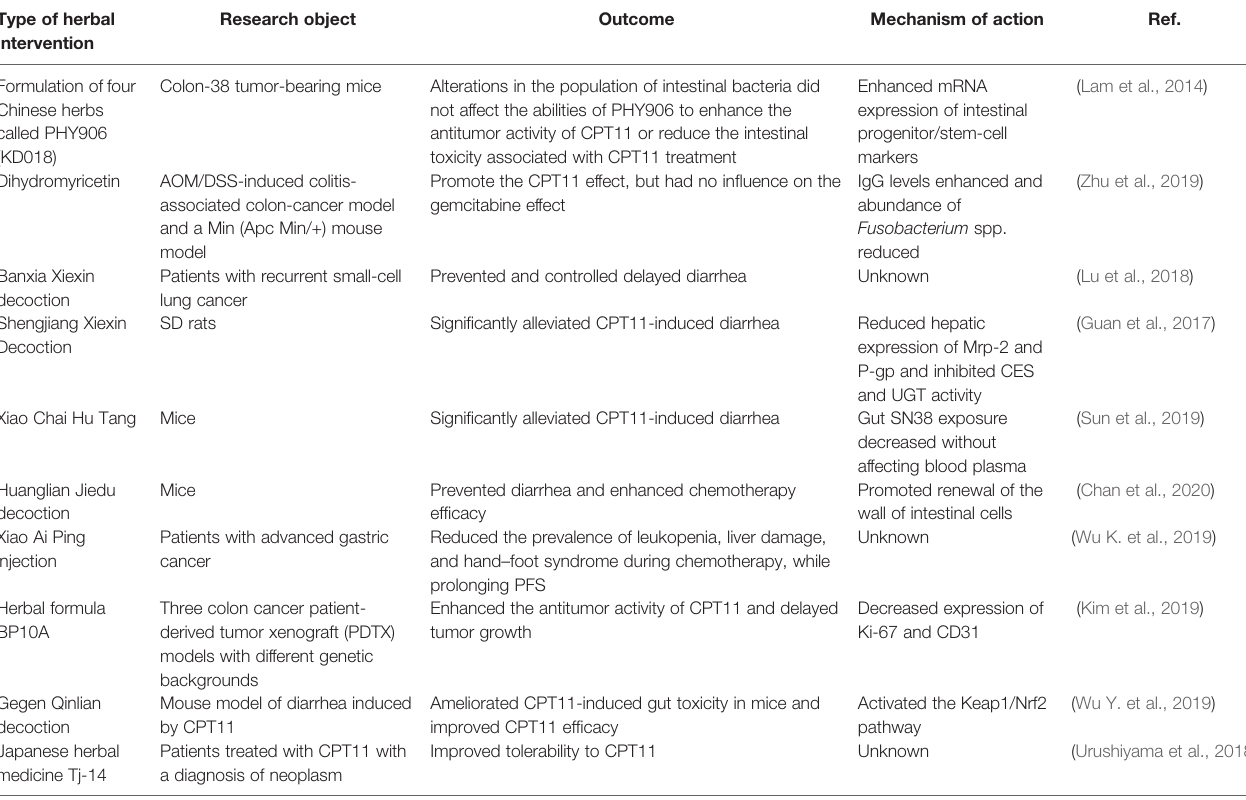
TABLE 3 | Outcomes of herbal interventions for CPT11